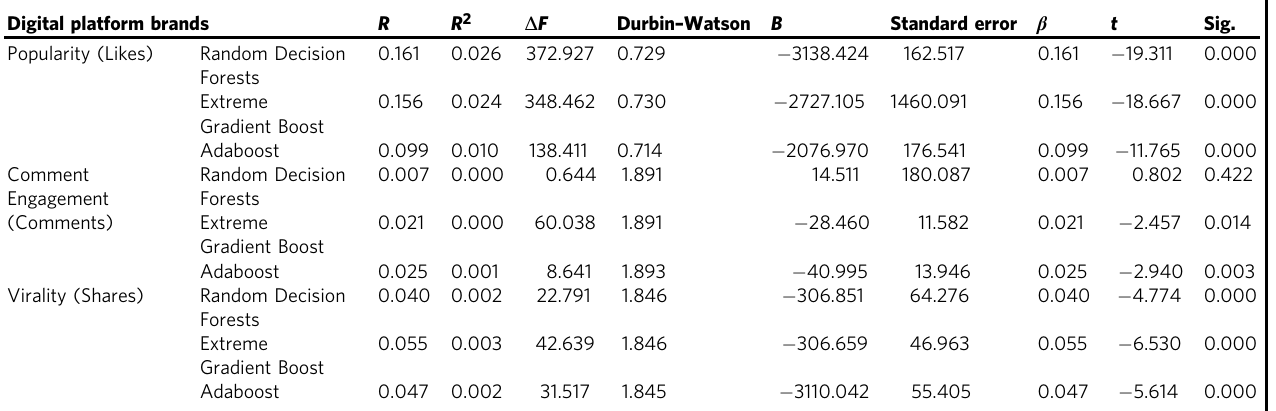
Table 4 Linear regression coef fi cient of determination and beta (digital platform